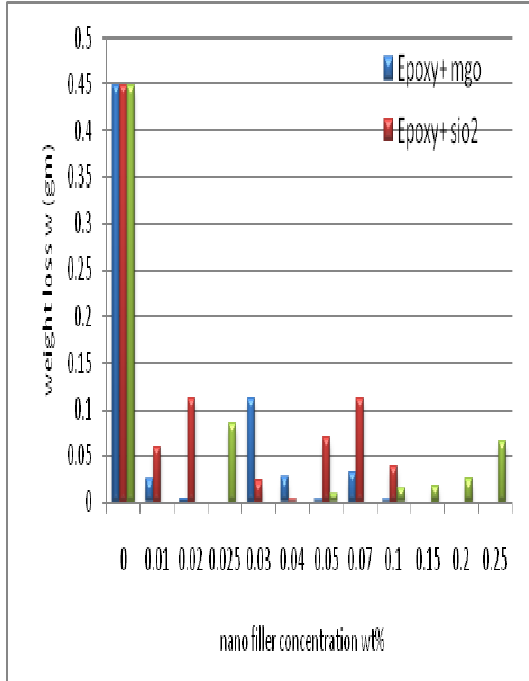
Fig. 3: The behavior of elastic modulus with nano filler concentration.